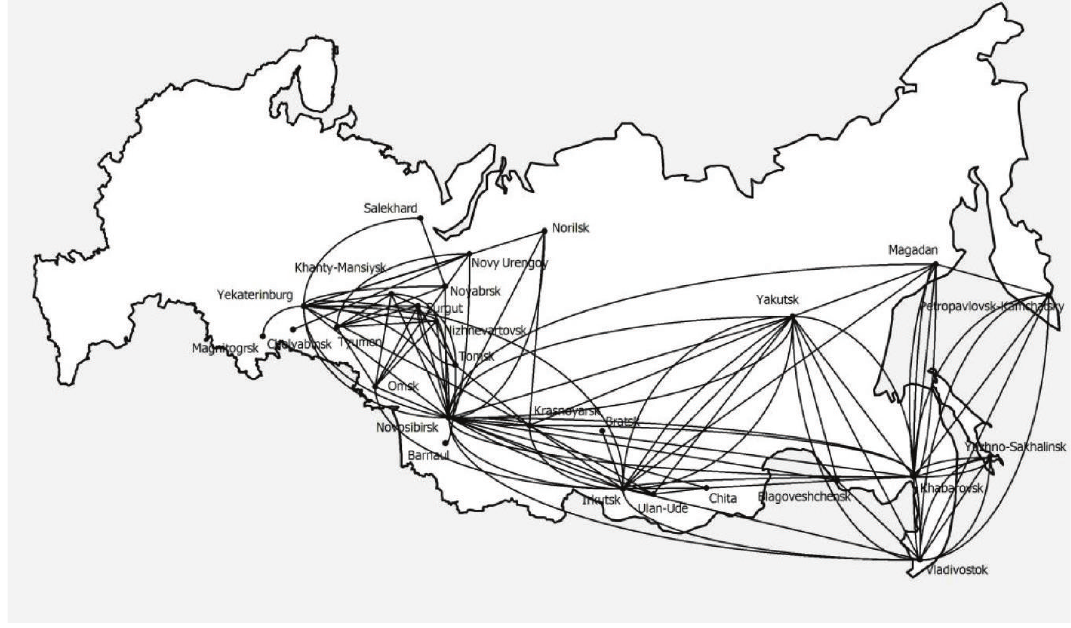
Figure 1: Russian airline market.